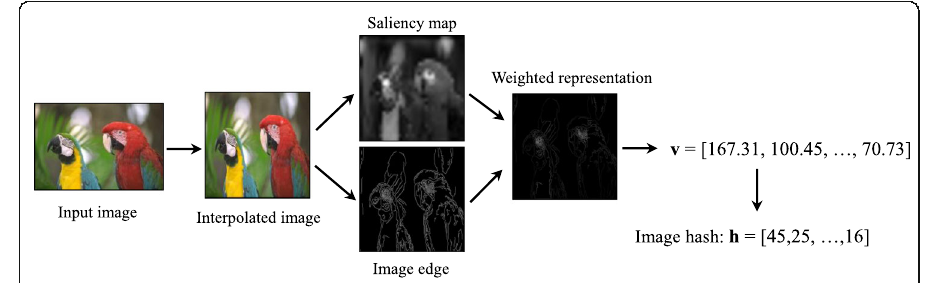
Fig. 4 A visual example of our hash